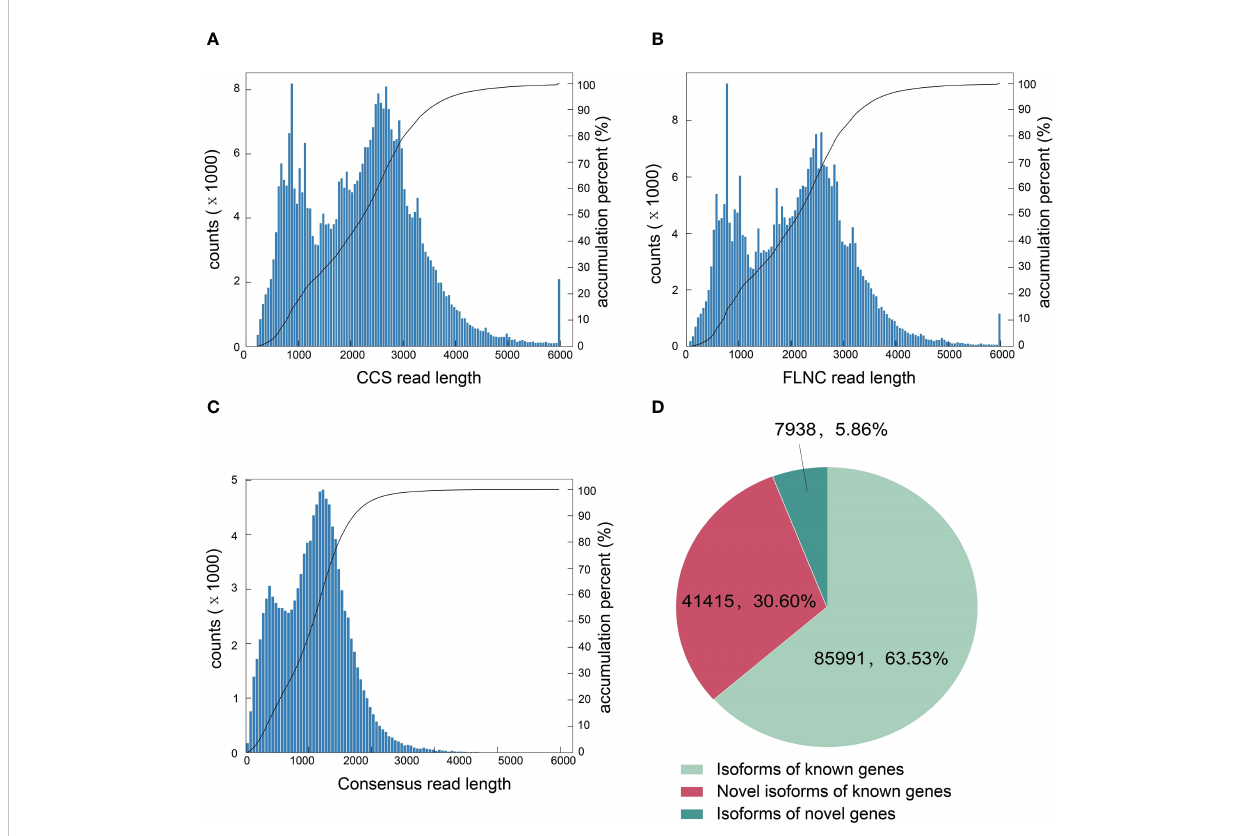
FIGURE 2 Characterization of tobacco full-length transcripts by PacBio SMRT sequencing. (A) The number of CCS reads in different lengths. (B) The number of FLNC reads in different lengths. (C) The number of consensus reads in different lengths. (D) Number and categories of isoforms based on the PacBio